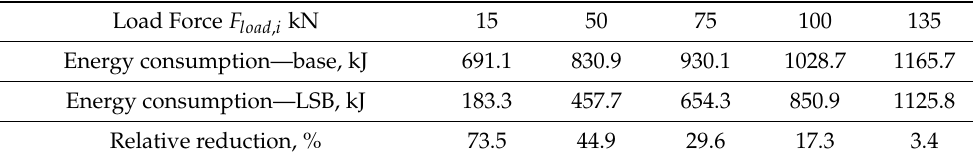
Table 3. Energy consumption, equal load force.